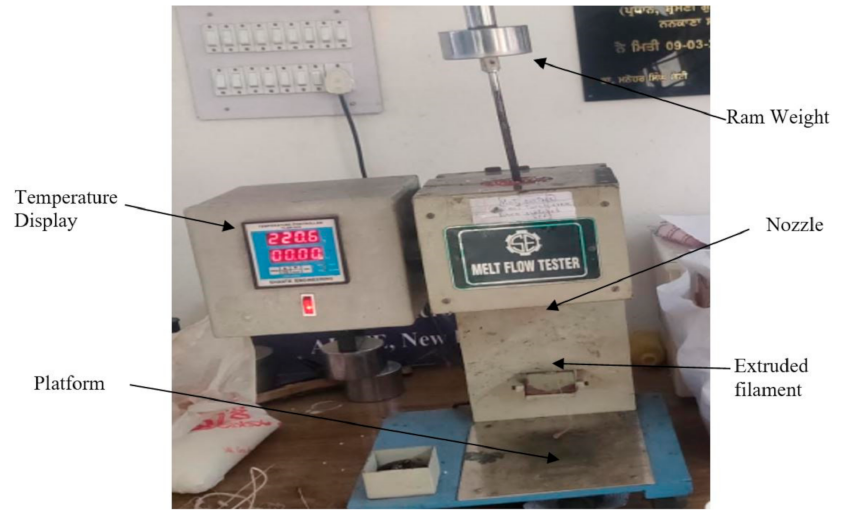
Figure 3. Melt indexer machine.